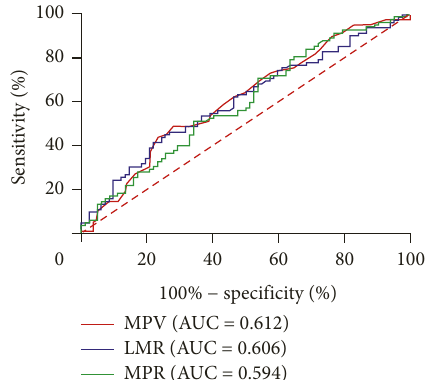
Figure 2: The diagnostic value of MPV, LMR, and MPR for RRD. Abbreviations: MPV, mean platelet volume; LMR, lymphocyte-to- monocyte ratio; MPR, MPV-to-platelet ratio; RRD, rhegmatoge- nous retinal